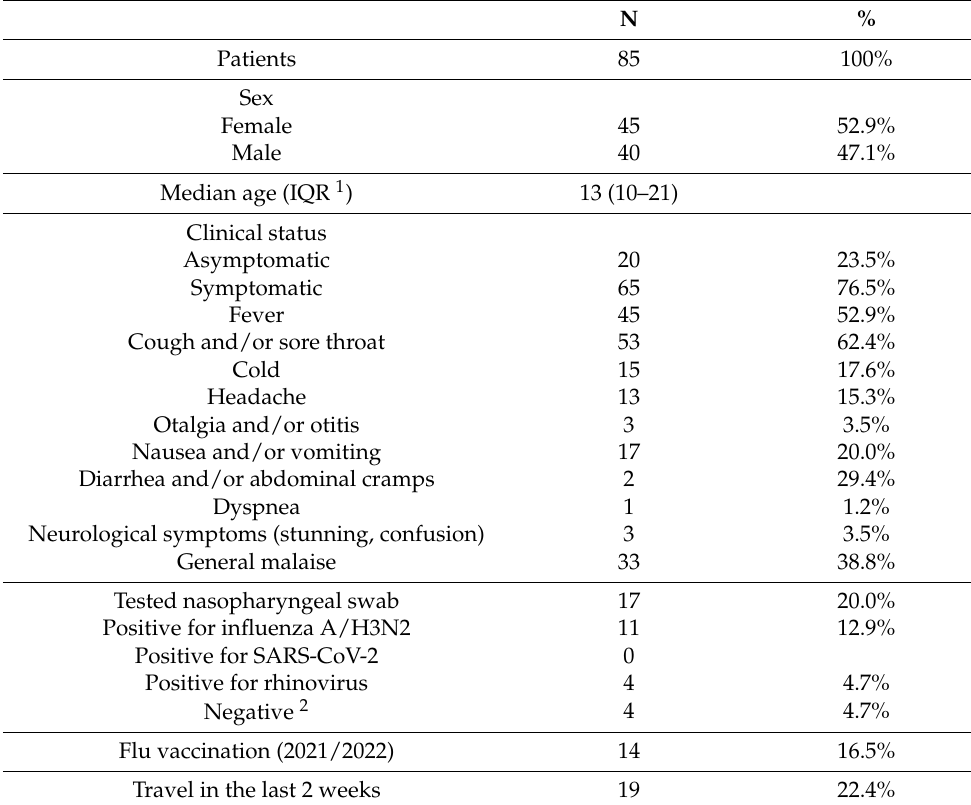
Table 1. Clinical and demographic characteristics of patients involved in an A/H3N2 influenza outbreak related to the religious retreat, in the Apulia region of Italy, in August 2022. N % Patients 85 100% Sex Female 45 52.9% Male 40 47.1% Median age (IQR 1